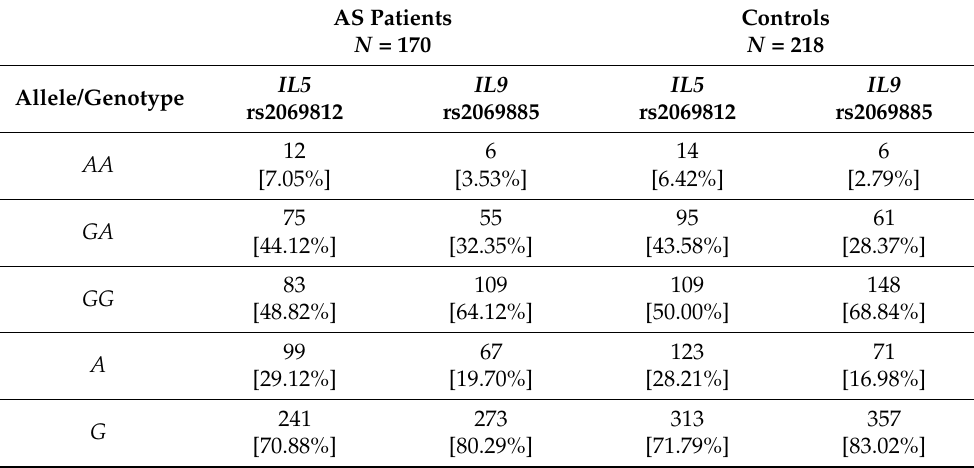
2.2. IL5 rs2069812 and IL9 rs2069885 Variants and Anti-TNF Treatment Response The group of patients involved in the study underwent treatment with TNF inhibitors with diverse outcomes after 12 and 24 weeks of therapy. Significant relationships between the IL5 rs2069812 and IL9 rs2069885 polymorphisms and response to anti-TNF treatment, expressed by the Bath Ankylosing Spondylitis Disease Activity Index (BASDAI) were ob- served. In both cases, the A allele was significantly more frequent in AS patients displaying lower BASDAI values (Figure 1). Carriers of the IL5 rs2069812 A allele showed significantly lower BASDAI values after 12 weeks of anti-TNF therapy than those with the GG genotype ( AA + AG vs. GG p = 0.022, Figure 1a). With regard to the IL9 rs2069885 polymorphism, the A allele was found to be significantly more frequent in patients with a better response to treatment compared to patients with the GG genotype ( AA + AG vs. GG p = 0.046, Figure 1b) after 24 weeks of therapy.